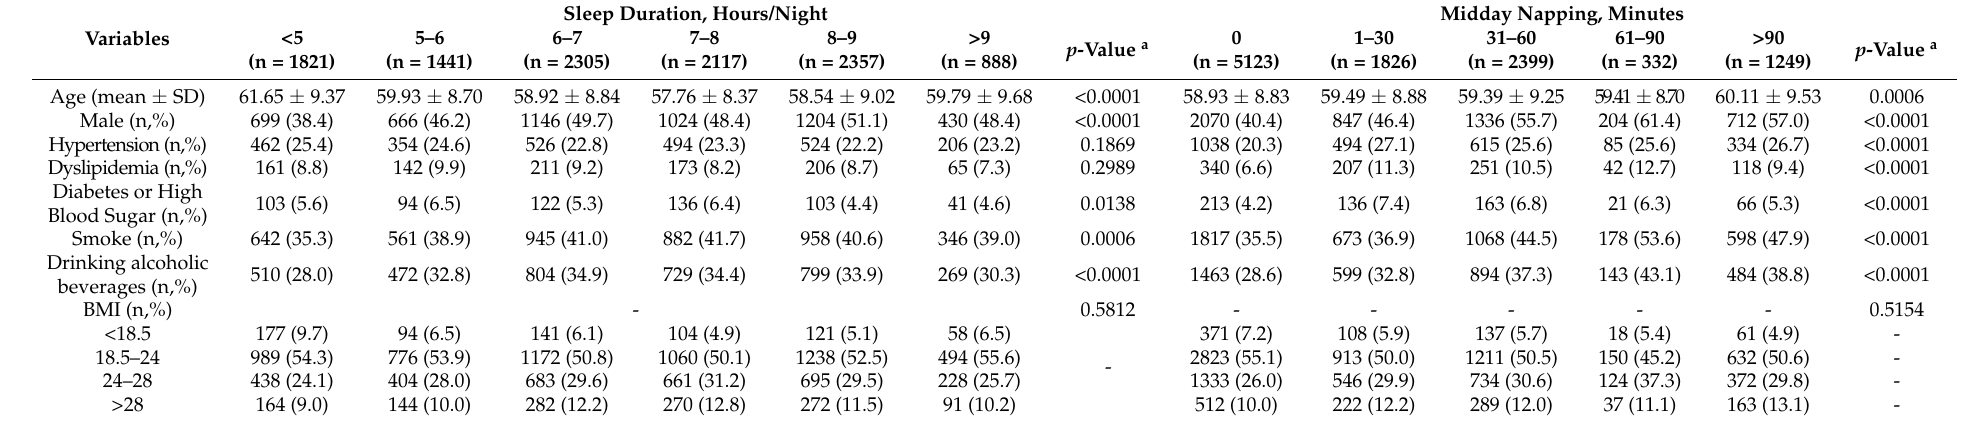
Table 1. Baseline characteristics of the study participants according to sleep duration and midday napping (n = 10,919).